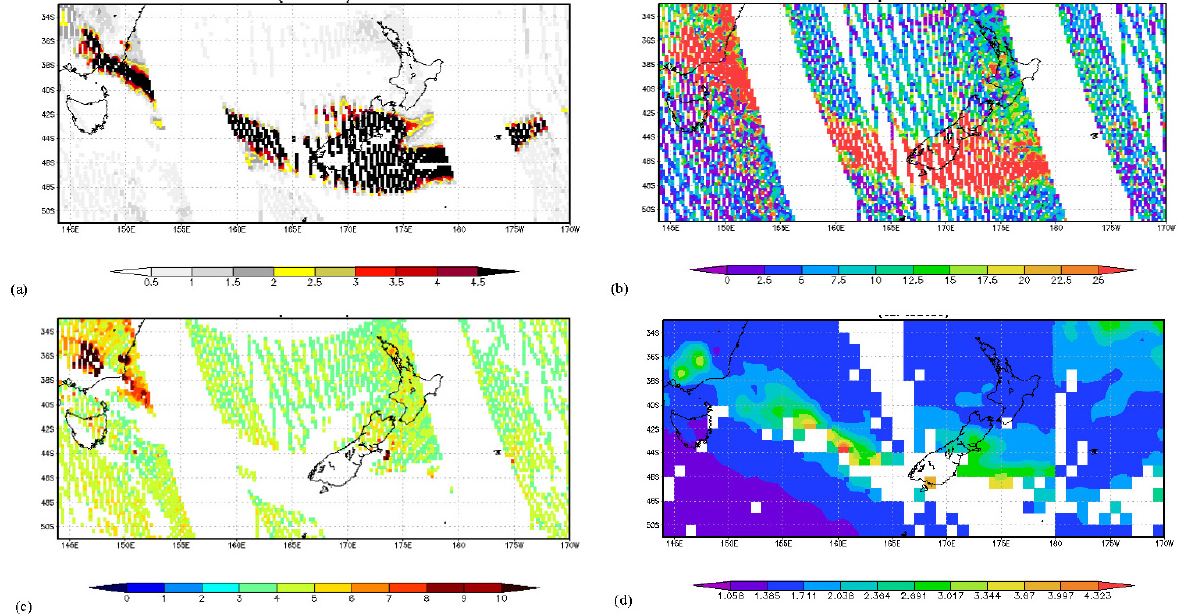
CO total 2 total column 2